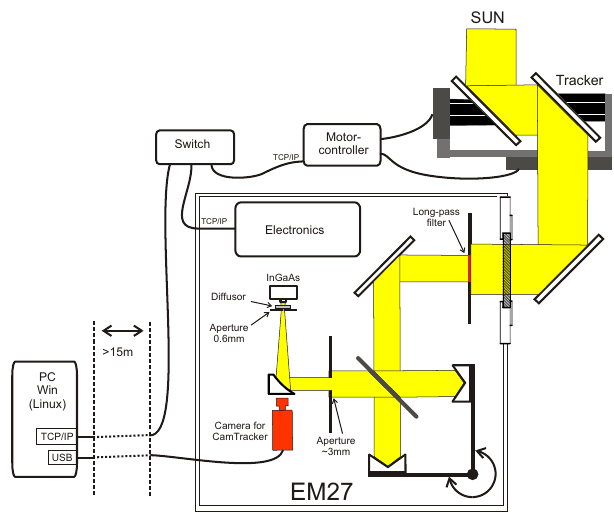
Fig. 3. Schematic drawing of our measurement setup and the EM27 spectrometer. The camera is not in the same plane as the mirror, instead it observes the field stop by a small angle from